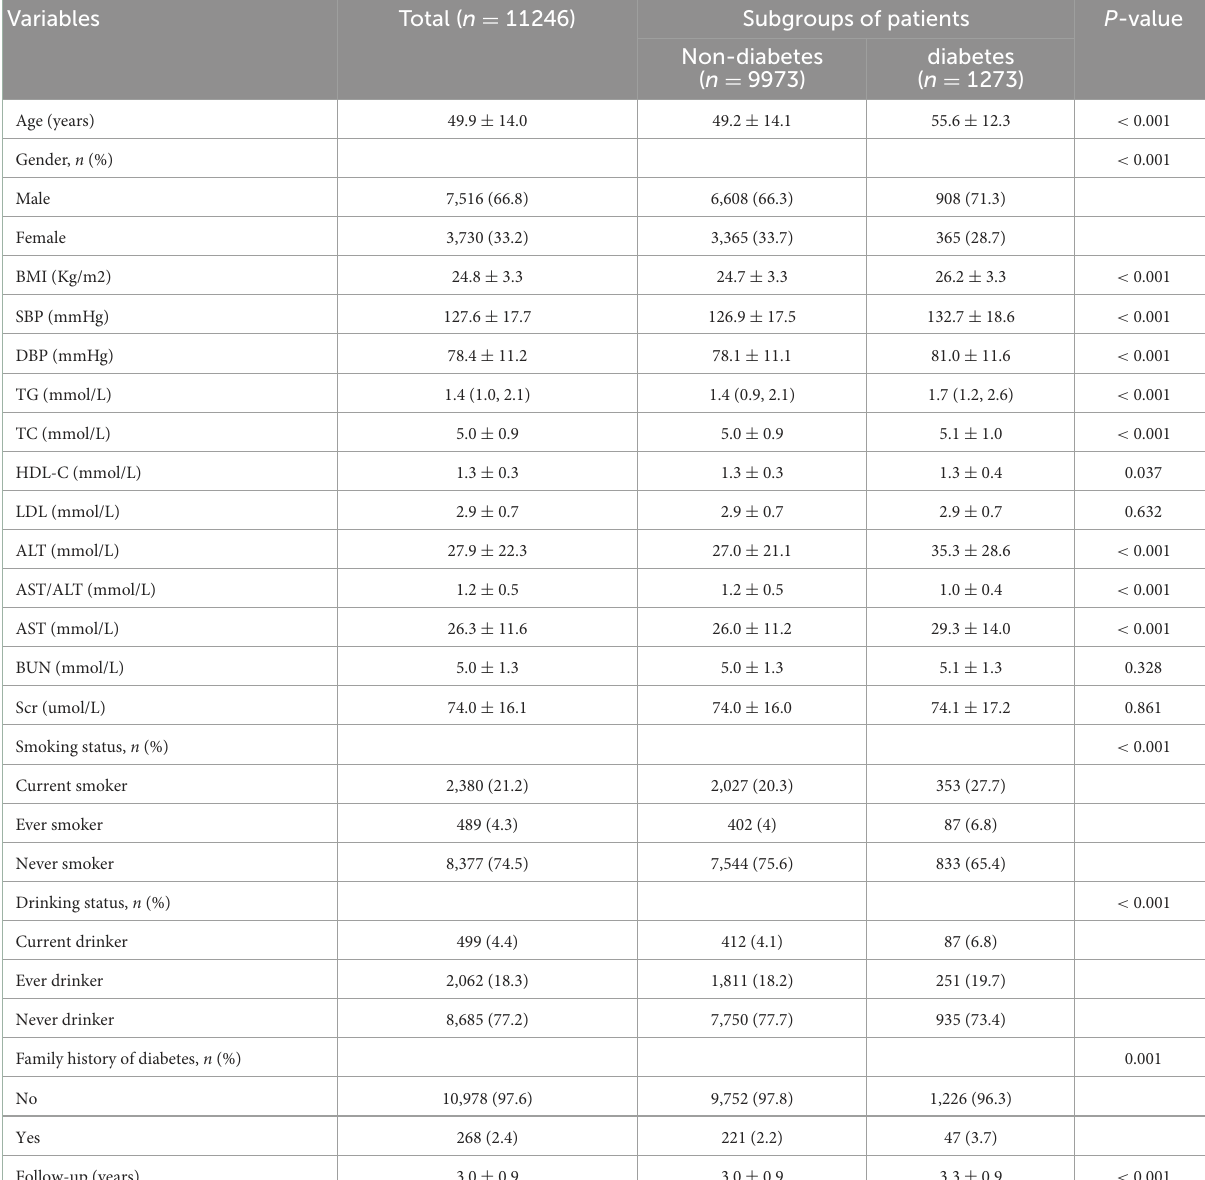
TABLE 2 Baseline characteristics of study participants with/without